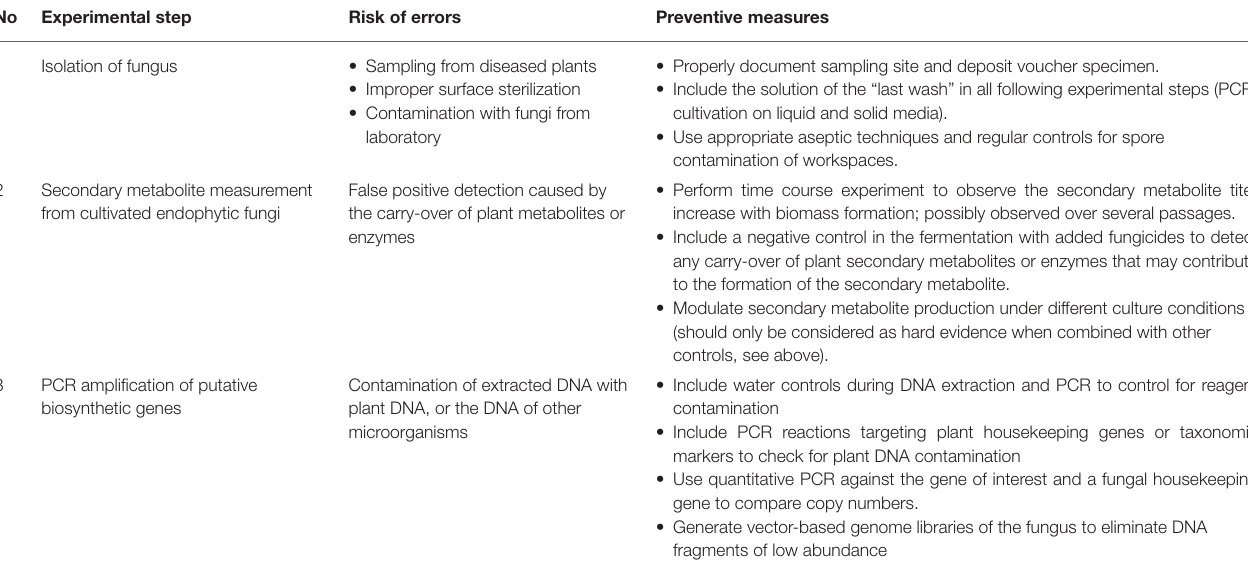
TABLE 1 | Possible sources of error when working with endophytic fungi and commonly used or suggested preventive